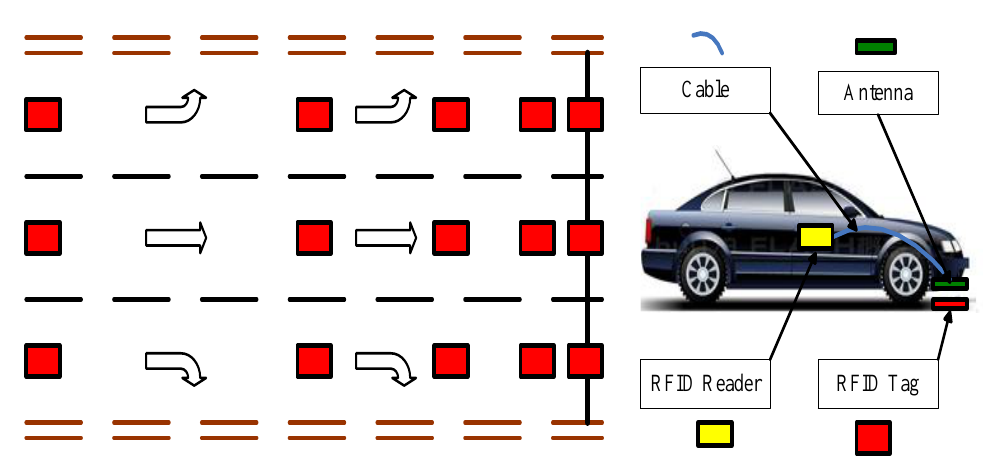
Figure 1. Layout of RFID tags and reader.